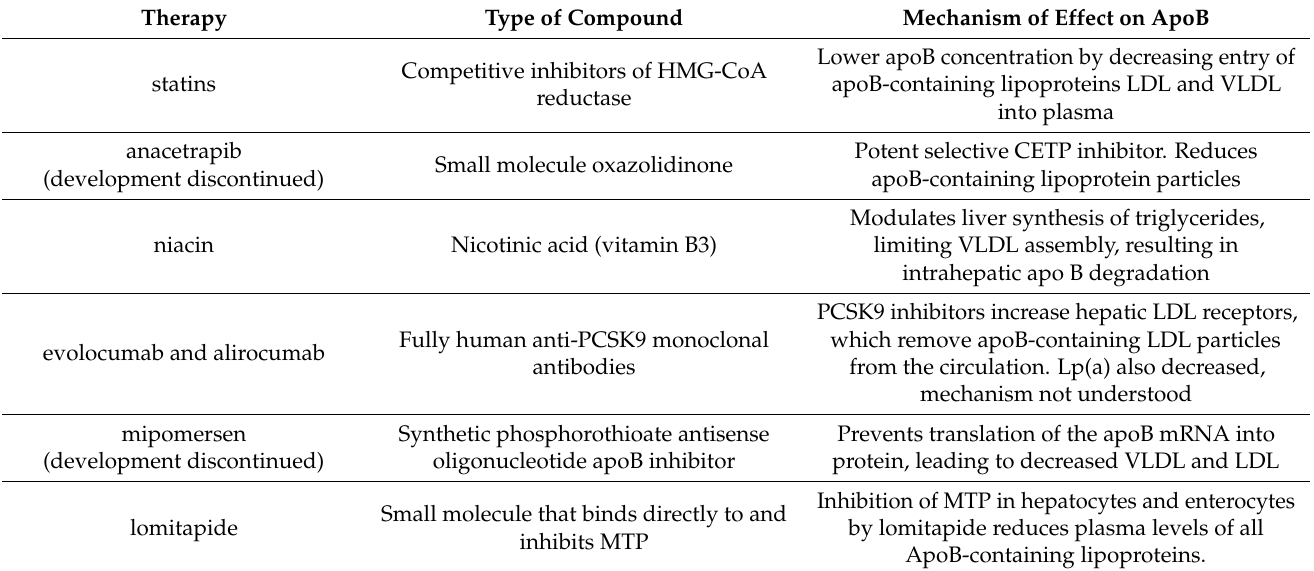
Table 1. Lipid-lowering therapies that reduce